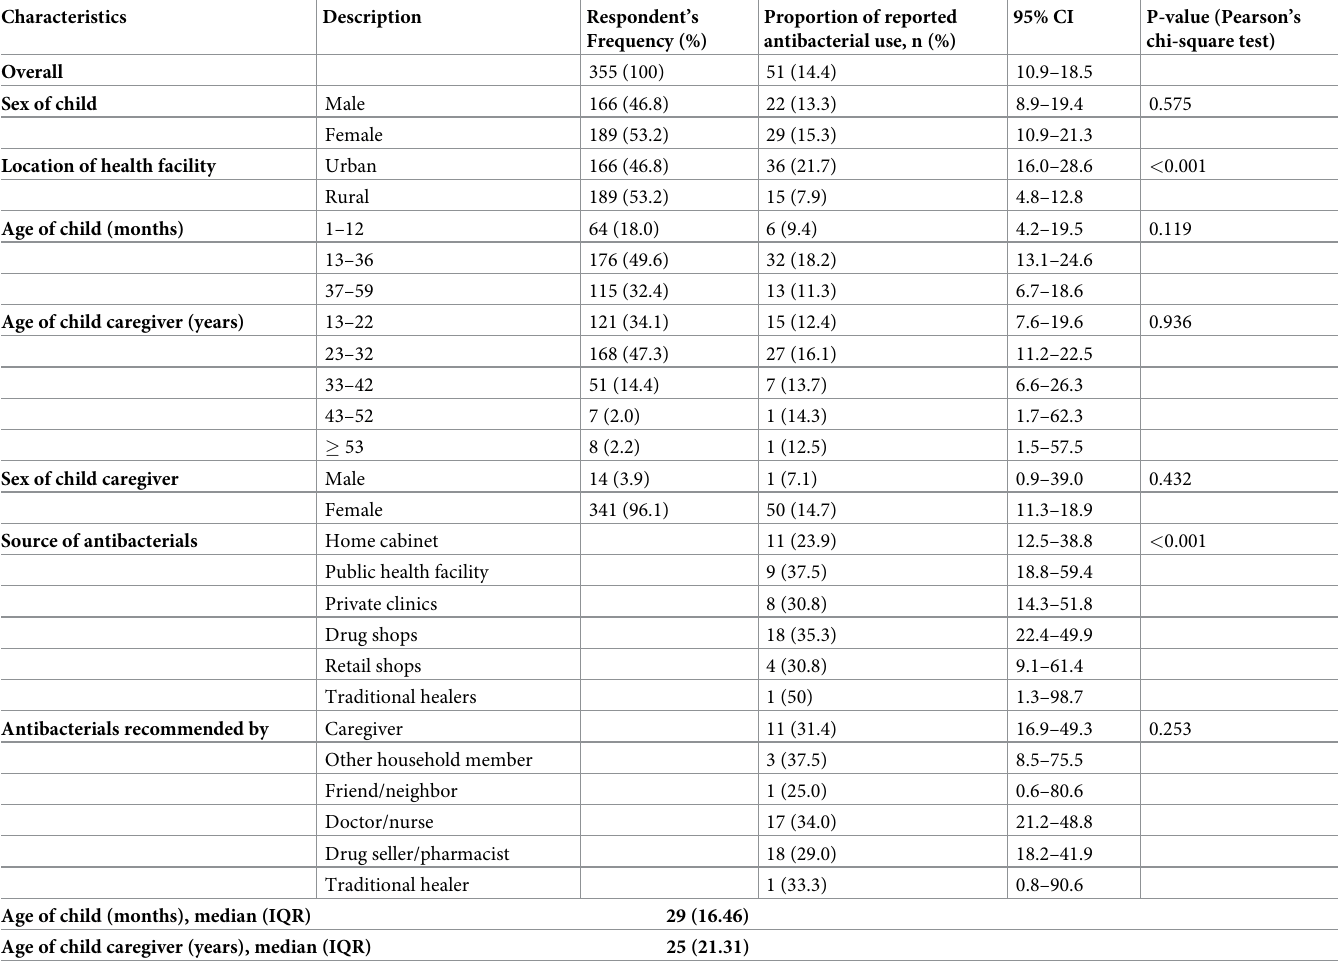
Table 1. Socio-demographic characteristics and prevalence of antibacterial use in children under five years prior to health facility visit as reported by caregivers of children under five years in rural communities of Gulu district, northern Uganda (August, 2019). Characteristics